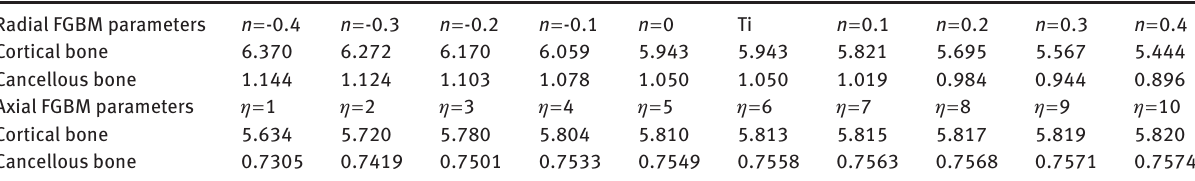
Table 4: Maximum von Mises stress (MPa) of cortical and cancellous bones in response to the titanium (Ti), radial and axial FGBM implants with various n and η values, respectively.